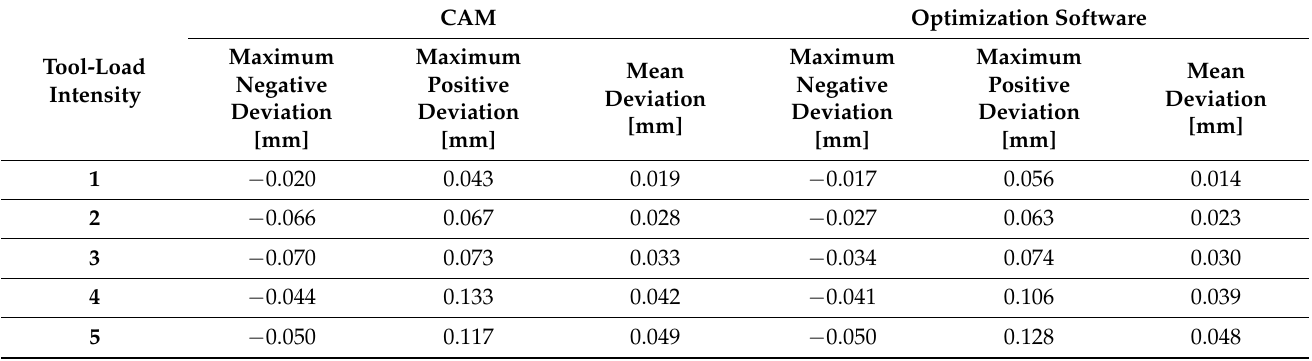
Table 4. Comparison of sidewall deviations of samples.